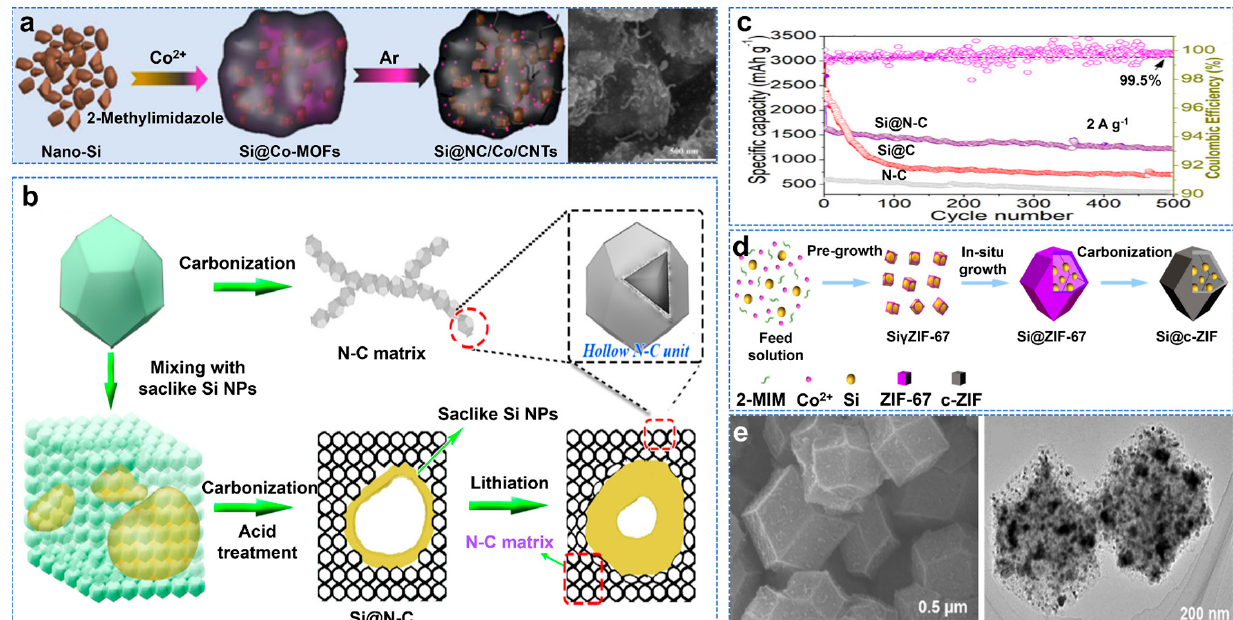
Figure 4. ( a ) Schematic illustration of the synthesis process for the Si@NC/Co/CNT composites and typical SEM images of sample [46]. ( b ) Schematic illustration of the fabrication of Si@N − C composite. ( c ) Cycle performance of Si@N − C, Si@C, and N − C at 2 A g − 1 [48]. ( d ) Schematic illustration of the synthesis of Si@c − ZIF. ( e ) TEM and HRTEM image of sample [49].